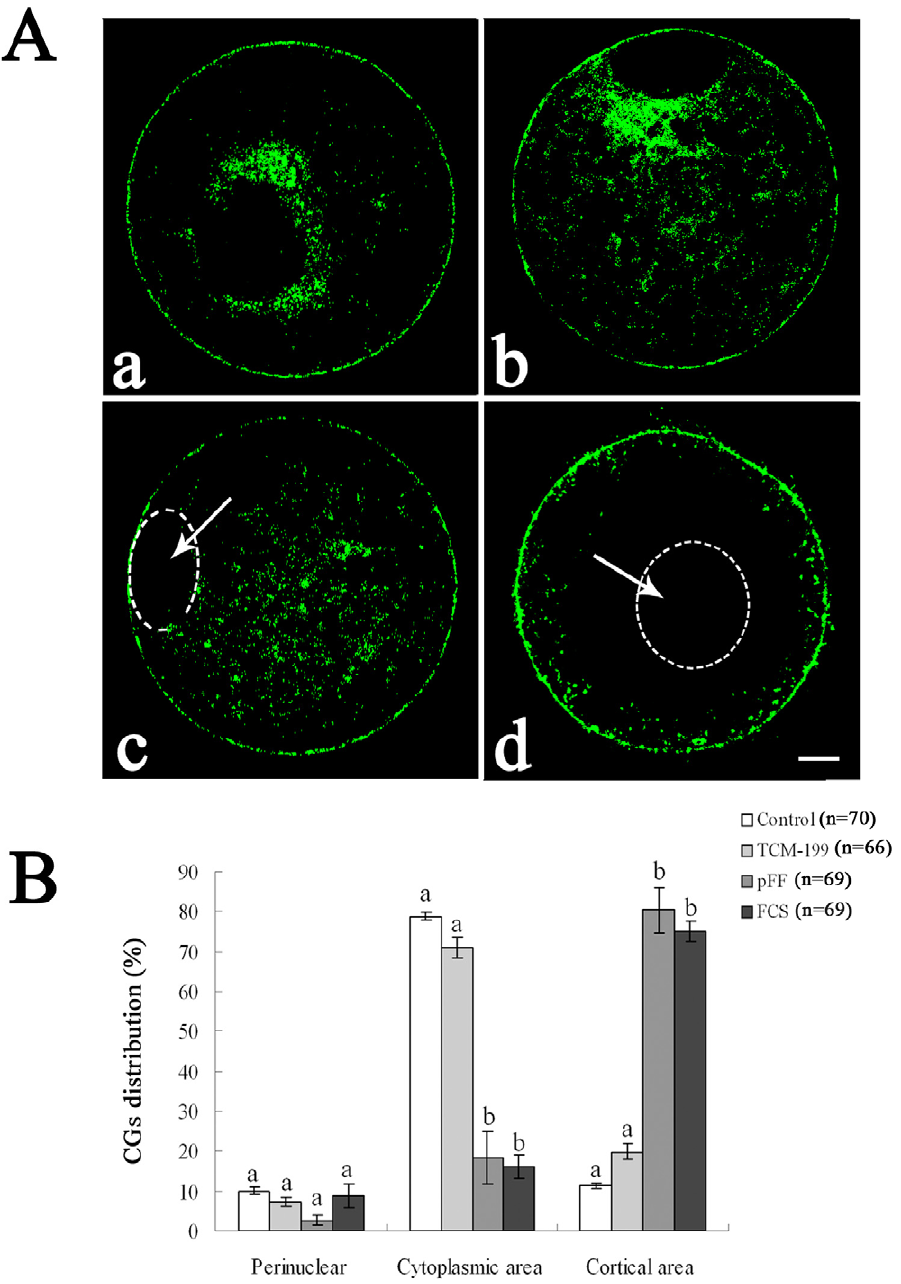
Figure 3. Effect of different media on CG distribution in porcine oocytes after preservation. A. a, b, CGs perinuclear area distribution within the porcine oocytes; a, most of the CGs aggregate in the perinuclear area, with a few migrating to the central inner cytoplasm or cortical area; b is intermediate pattern between a and c, with most of the CGs still remaining in perinuclear area and some migrating to the central cytoplasm; c, CGs distributed uniformly in the inner cytoplasmic area, and a few migrated to the cortical area to form a discontinuous ring; d, CGs cortical area distribution; almost all of the CGs have migrated into the cortical area, and a few still remained in the central cytoplasm. Green, cortical granules. Scale bar=10 m m. (White arrows pointing at the white circle denotes the germinal vesicle). B. Ratios of different CG distribution patterns within the porcine oocytes after preservation in different media. Porcine oocytes were preserved in TCM-199, pFF and FCS at 27.5 u C for 3 d, and then CG distribution was stained with FITC-labeled peanut agglutinin. Three categories of CG distribution were detected: perinuclear area; inner cyoplasmic area; cortical area. The graph shows the mean 6 SEM of three independent experiments. The number ‘‘n’’ in the bracket means the total treated oocyte in every group. The superscripts a, b over the bars represent values that differ significantly in every categories of CG distribution (P , 0.05). doi:10.1371/journal.pone.0014242.g003 distribution of F-actin was similar in GV stages among fresh, pFF For many species, CG migration and mitochondrial distribution and FCS groups, indicating that pFF and FCS do not disturb actin are regarded as clear indications of oocyte cytoplasmic maturation organization. [17]. During oocyte growth and maturation, CGs migrate to the